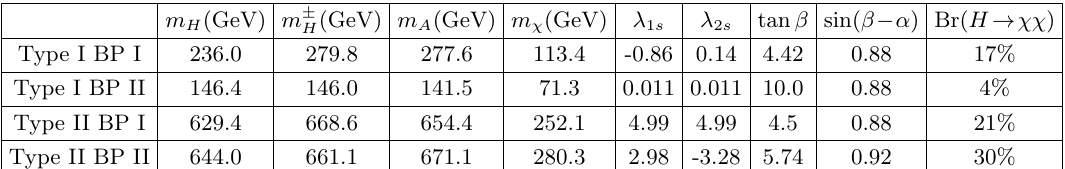
Table 2 . The Benchmark points for Type I and Type II